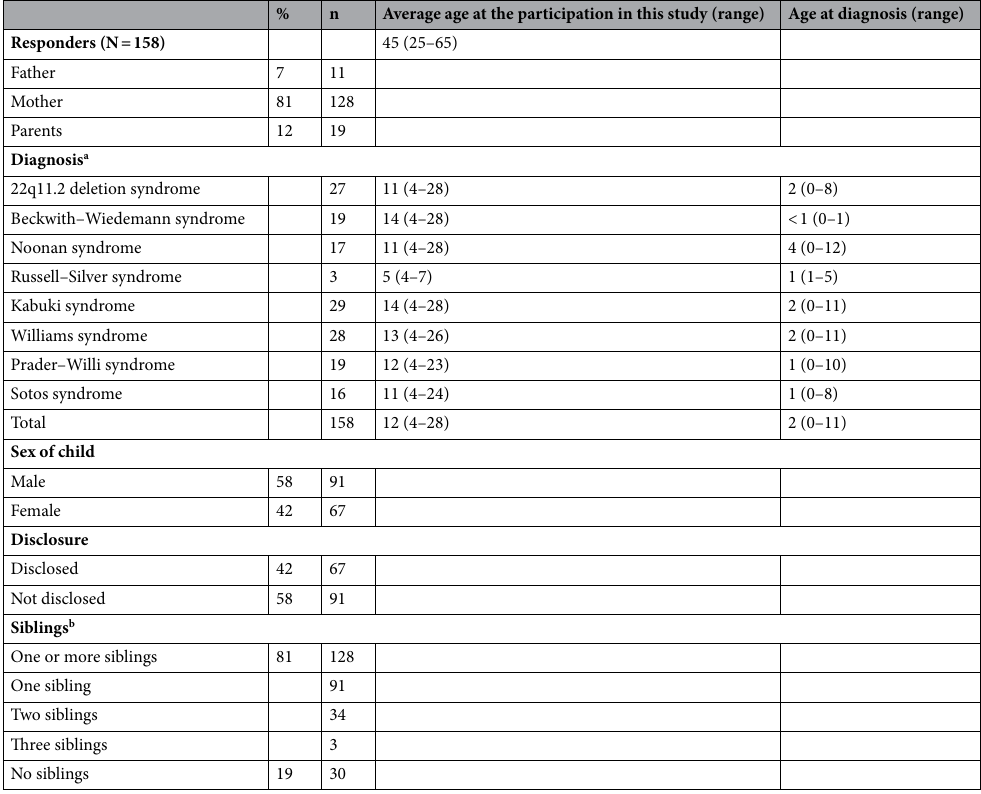
Table 2. Classification of responders, sex, diagnosis, and age of children, and number of siblings. a The diagnosis and ages of each child with a genetic condition. b Ages of siblings neither at the participation in the study nor at the diagnosis of children with genetic condition was not provided. Ages at disclosure of genetic condition are shown in Fig. 2.